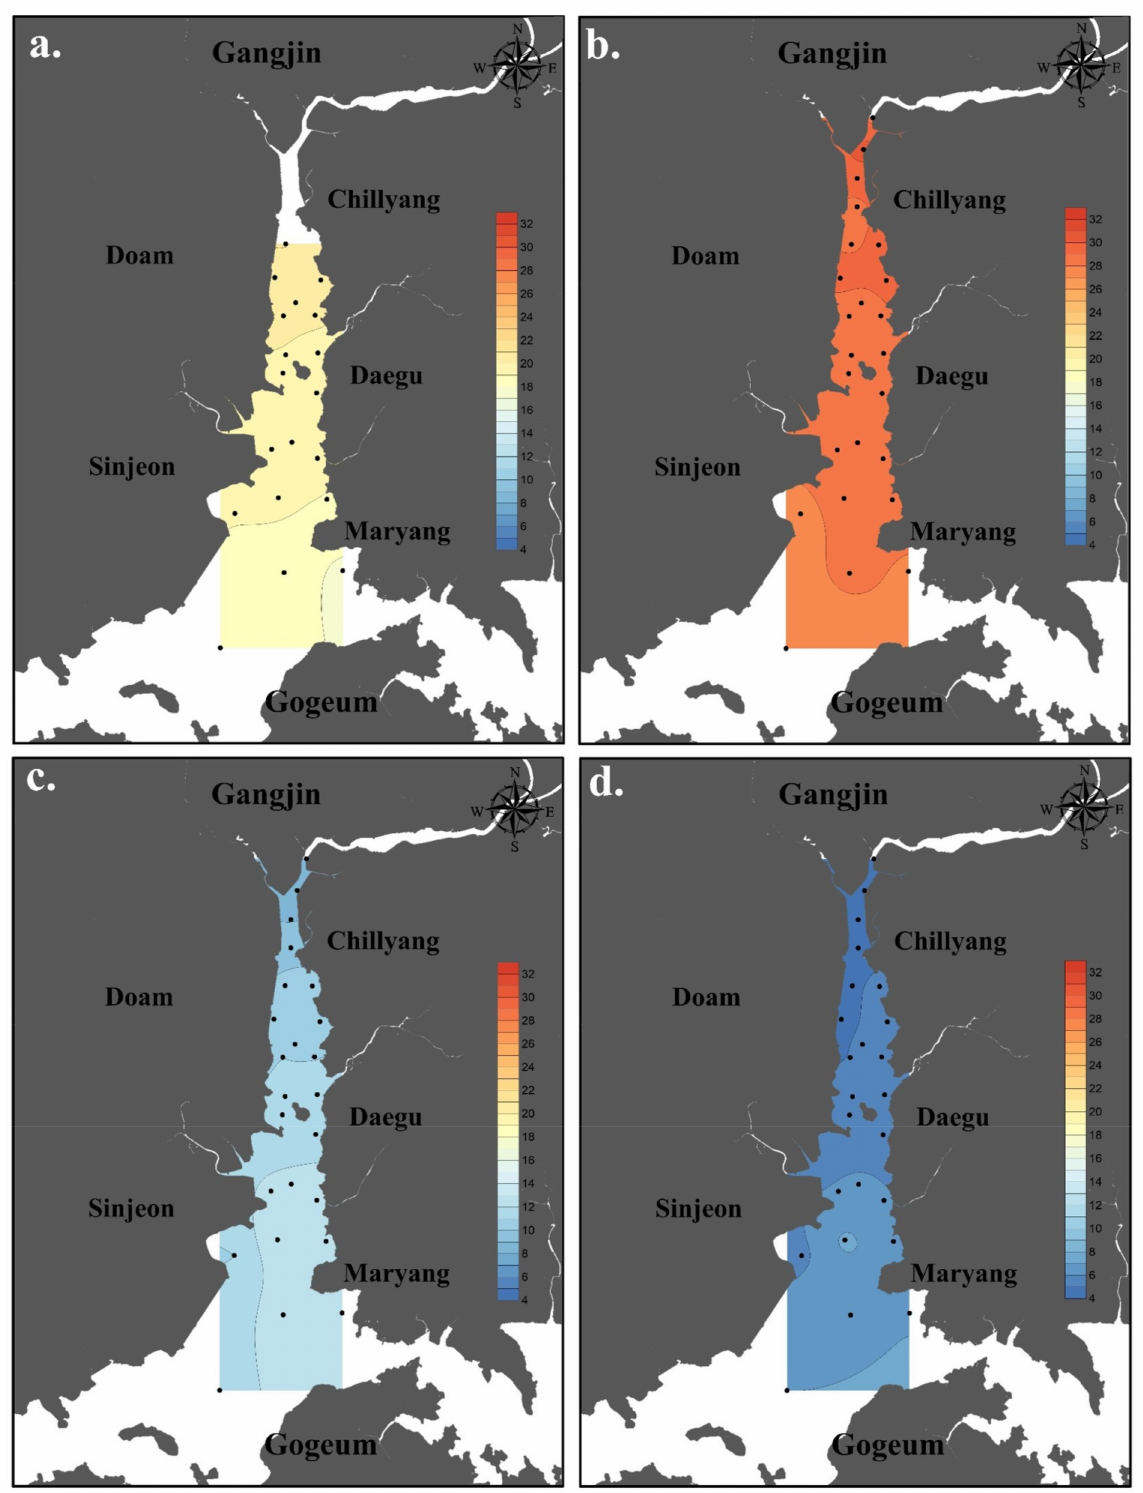
Figure 2. Horizontal distribution of surface water temperature ( ◦ C) during the study period: ( a ) spring, ( b ) summer, ( c ) fall, ( d )